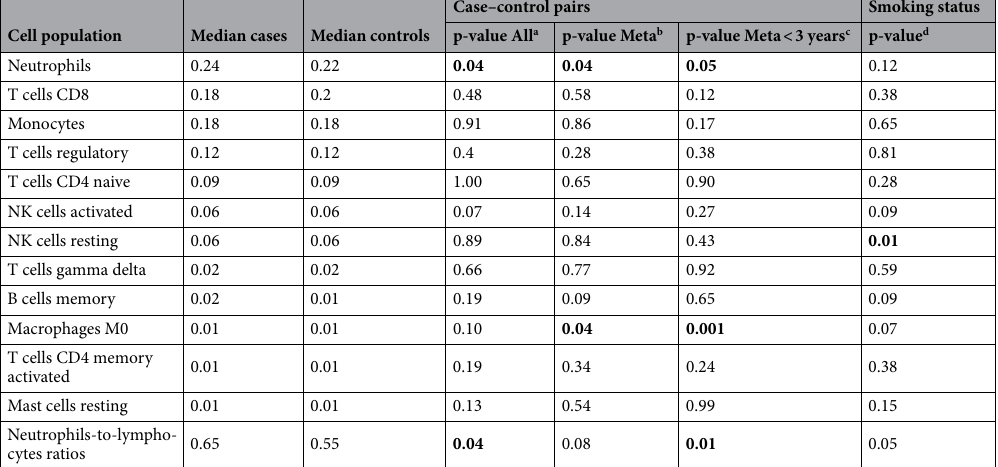
Table 3. Summary statistics for the estimated proportions of white blood cell populations in the samples with p-values for tests of differences according to case–control status and smoking status. Median values for cases and controls in the subgroups analyzed and in smoking status groups are presented in Table S1. B cells naïve, dendritic cells activated, dendritic cells resting, eosinophils, macrophages M1, macrophages M2, mast cells activated, plasma cells, T cells CD4 memory resting, T cells follicular helper were estimated as not present in the blood samples. a p-value for Wilcoxon Rank Sum group test including all case control pairs (n = 128 pairs). for Wilcoxon Rank Sum group test including all case control pairs (n = 36 pairs). d p-value for Kruskal–Wallis group test including current (n = 121), former (n = 71) and never (n = 64) smokers. Bold values indicate values below 0.05